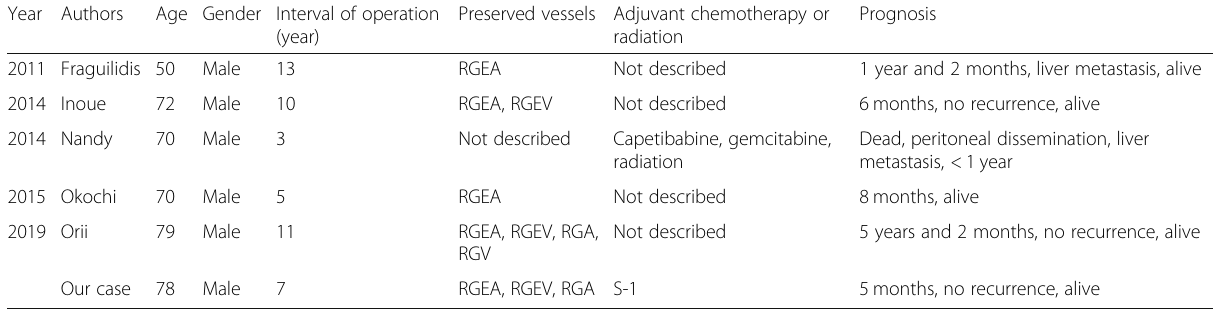
Table 2 Pancreaticoduodenectomy for pancreatic cancer after esophagectomy for esophageal cancer Year